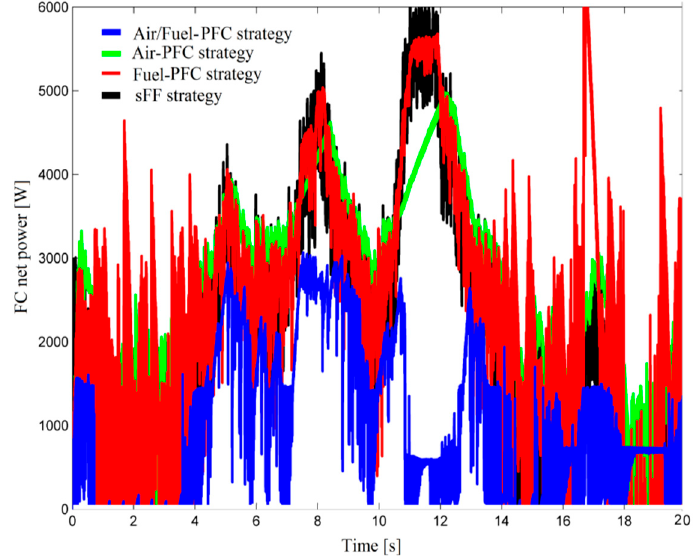
Figure 14. FC net Figure 14. FC net power.